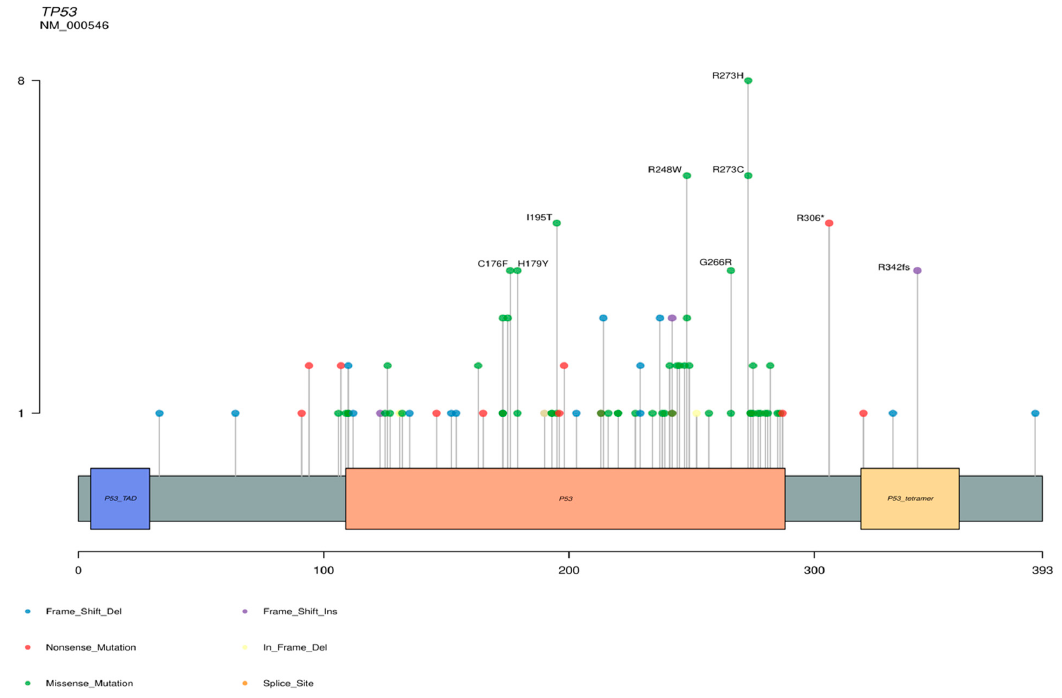
Figure 4. Representation of the distribution of mutations in the TP53 gene. (*) Nonsense mutation. (fs) FrameShift mutation. These data were obtained from the review of reference [11].